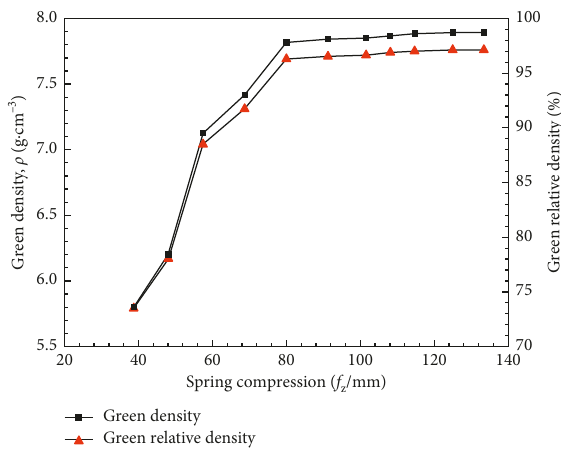
Figure 15: Spring compression versus green density.